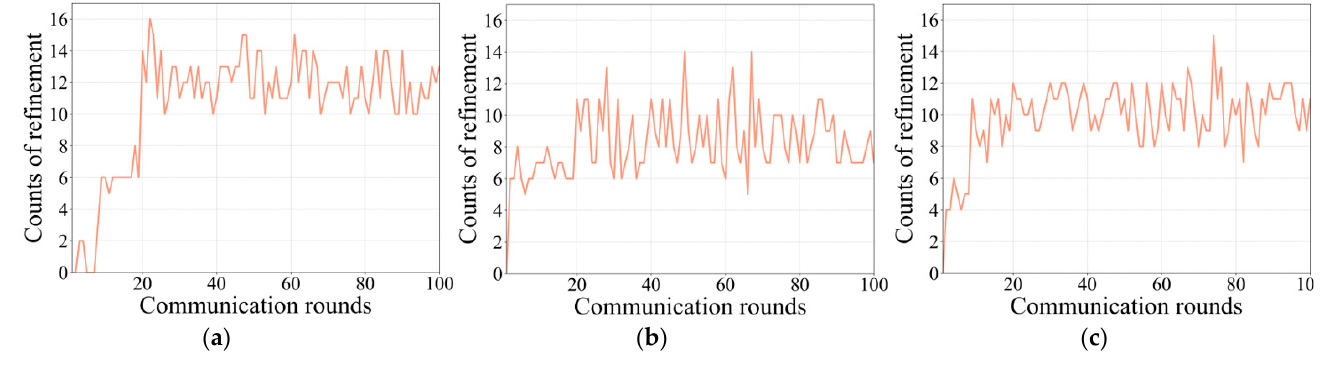
Figure 4. Counts of refinement operations during the training process over three runs from ( a – c ).